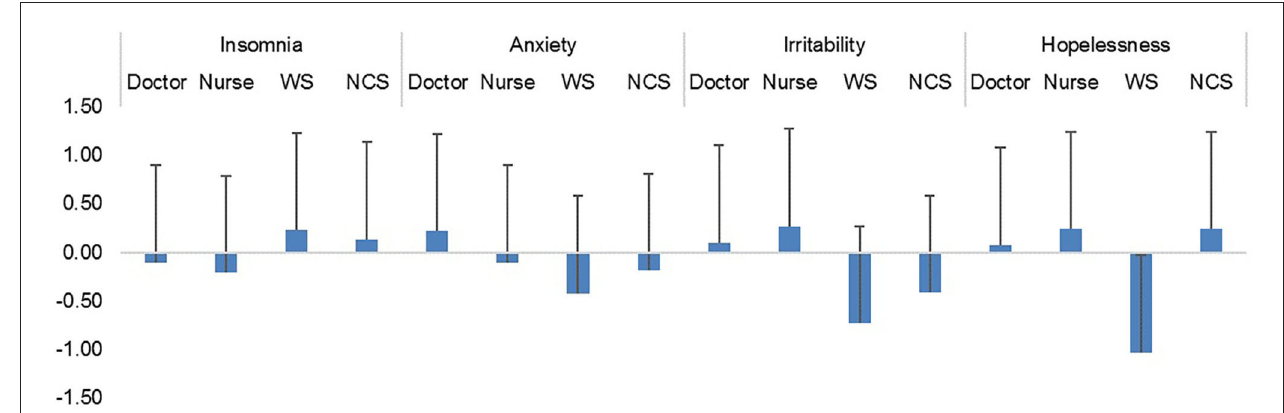
FIGURE 1 | Mean scores of different categories of health care workers.